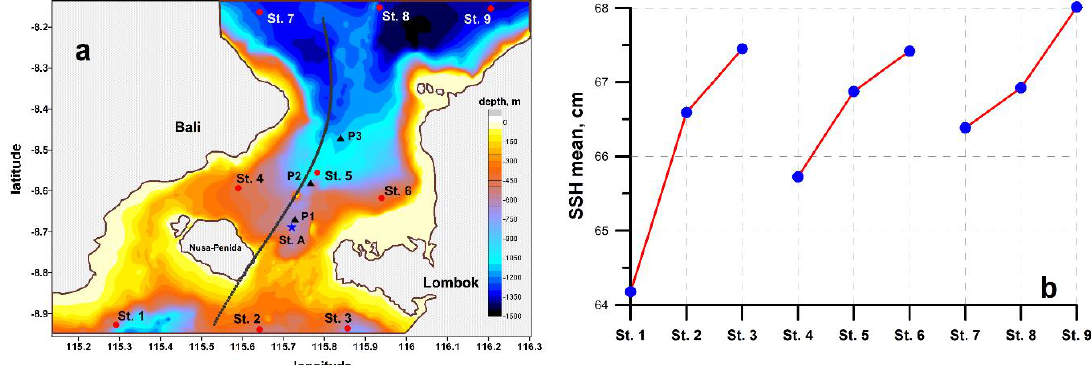
Figure 2. ( a ) Bathymetry map of the Lombok Strait with the location of the 9 stations for sea surface elevation analysis from FESOM1.4 global model [38] and black triangles (P.1–P.3) indicate the position of three points for spectral analysis; blue star indicates the position of station A; black line indicates cross-section along the strait. ( b ) The mean sea level for several years (2000–2009) at the chosen stations 1–9.